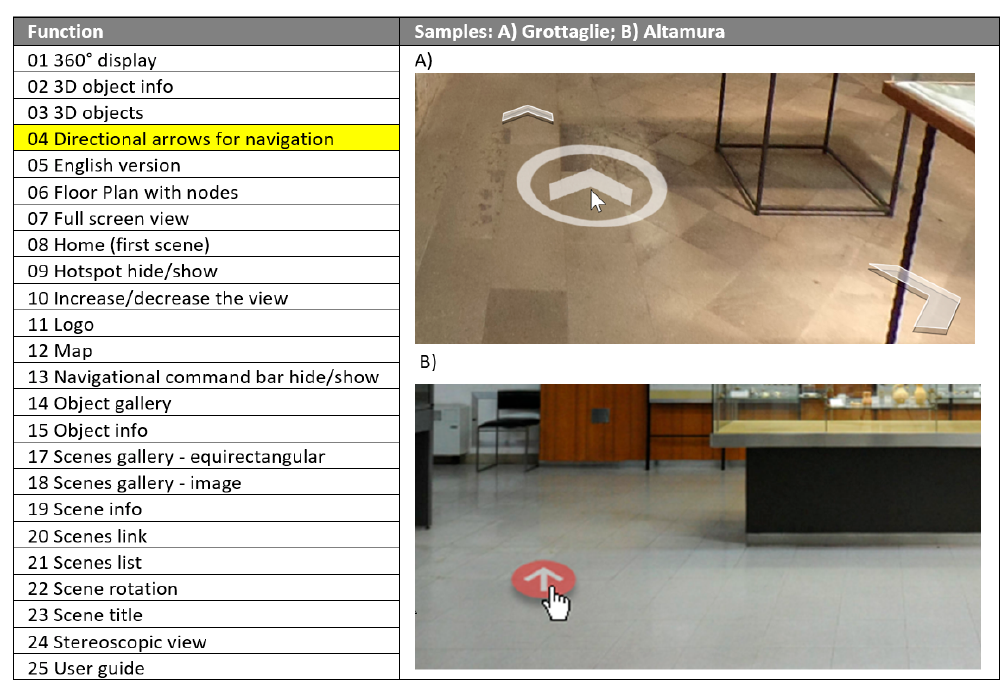
Figure 8. Virtual tour functions sample catalog.